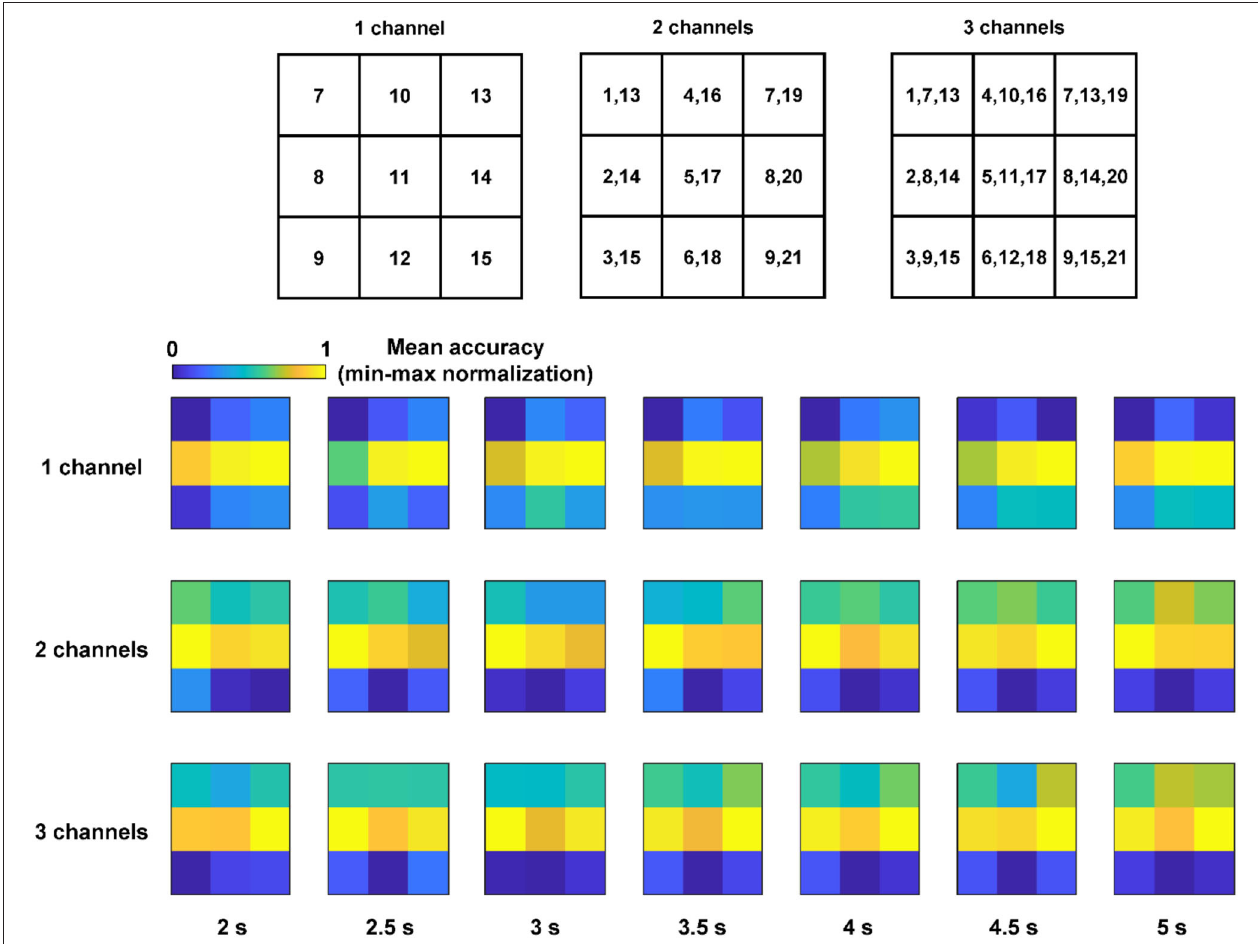
FIGURE 4 | Nine channel combinations corresponding to the cases, in which all the electrodes shift to the same direction and the mean accuracies across the subjects of the nine-channel combinations (accuracies were calculated using EMSI and the nine mean accuracies all the cases with various number of channels and each window length were min–max